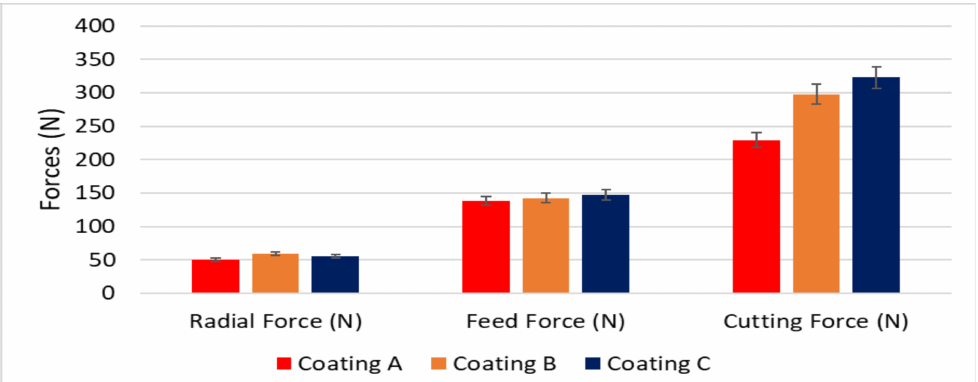
Figure 5. Variation of cutting forces for the three TiB 2 coated